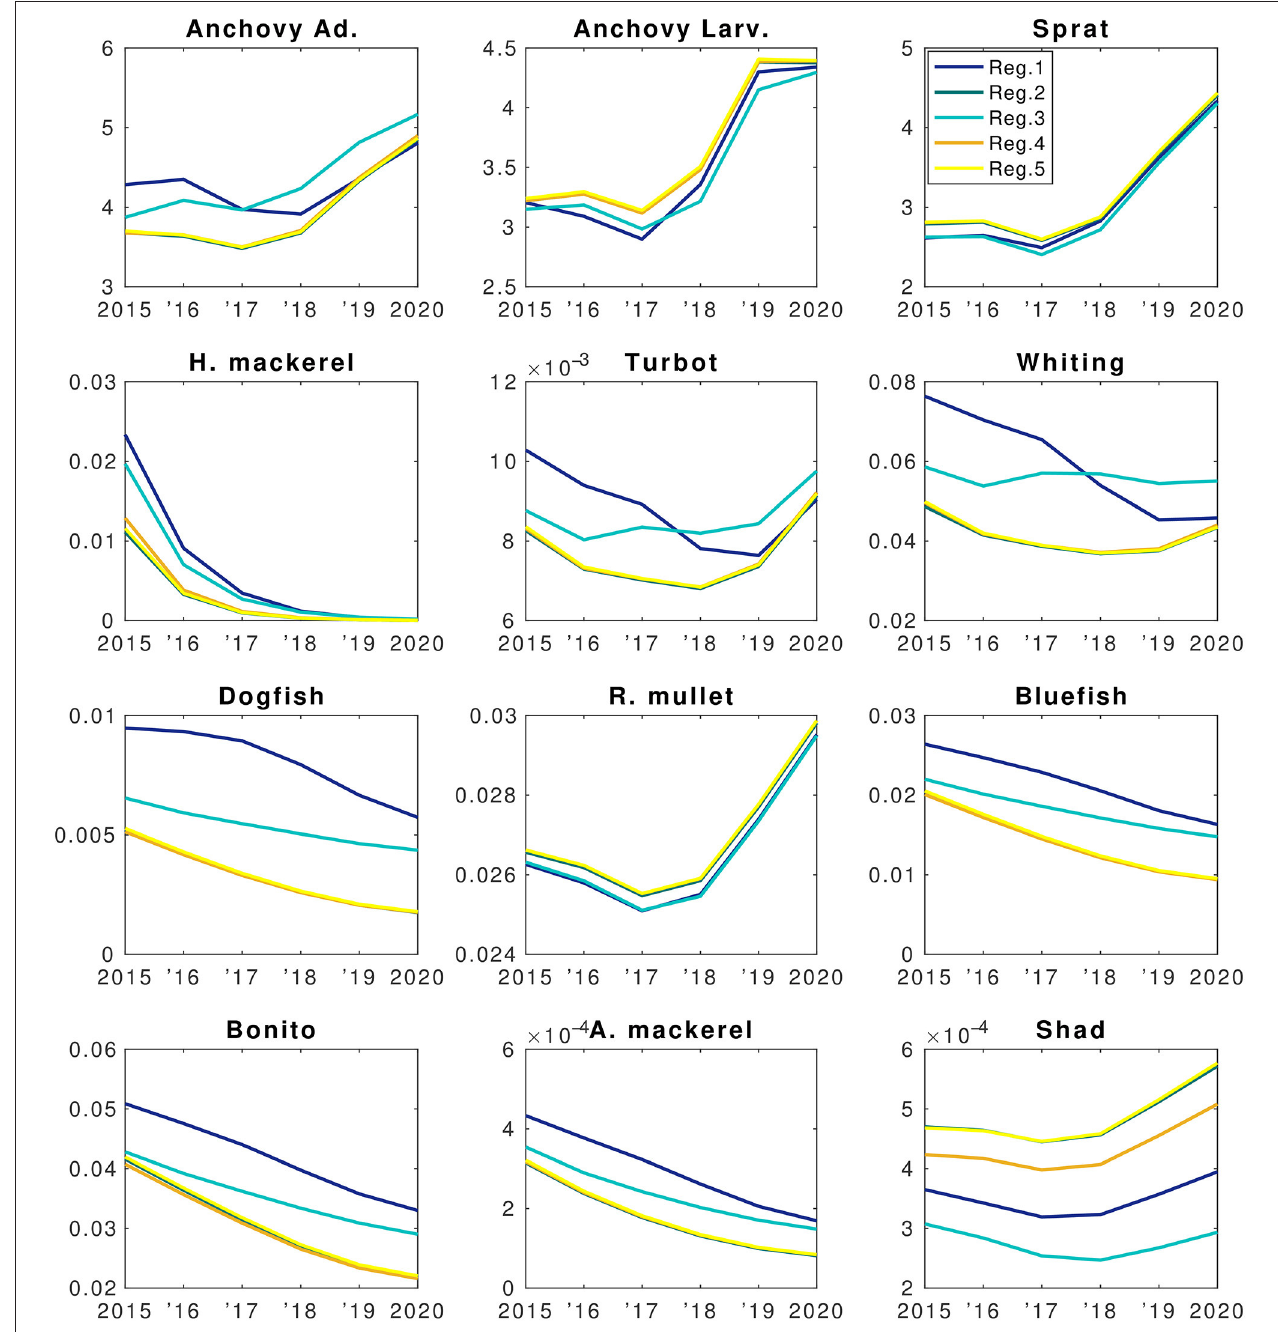
FIGURE 11 | Forecast simulation (2015–2020) results of the EwE fish model of the BAU scenario. X-axis denote years and Y-axis denote changes in biomasses (B.) The units are in tons km − 2 . Colors denote different regions as explained in the top right